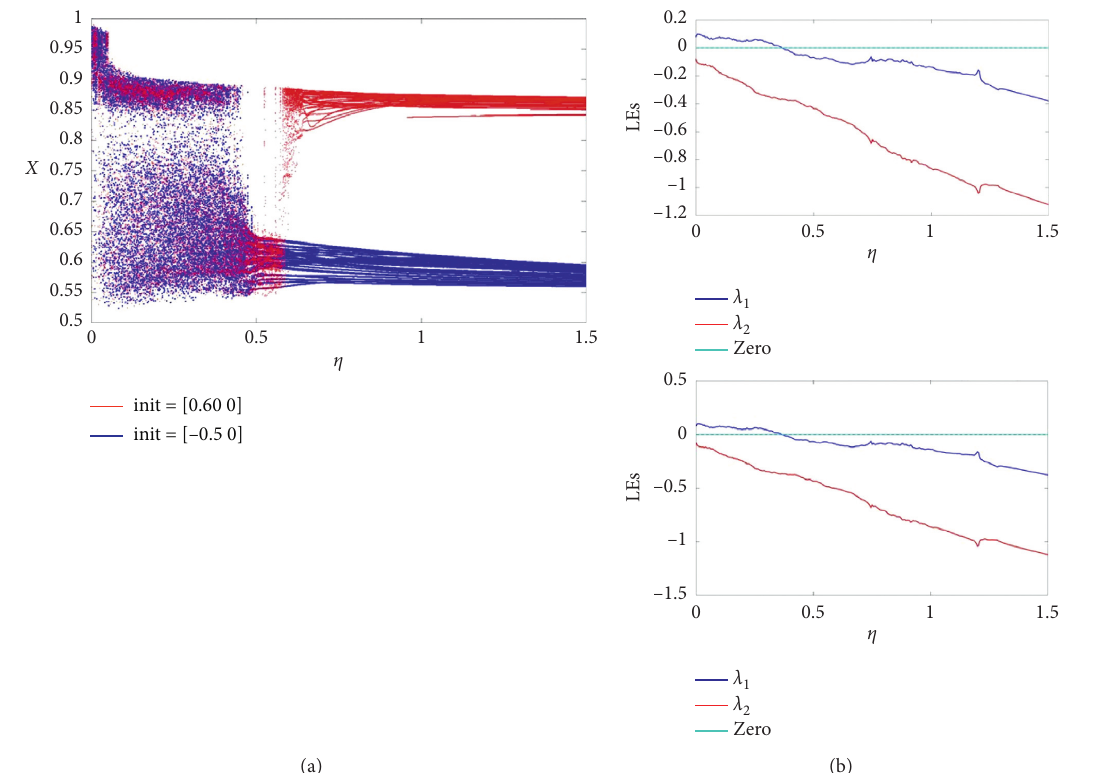
Figure 7: (a) Bistability of system (8) with the blue plots showing the forward continuation (increase parameter η from 0 to 1.5) and the red plots showing backward continuation (Decrease parameter from 1 to 0) with reinitialization of the initial conditions. (b) Corresponding Lyapunov exponents.